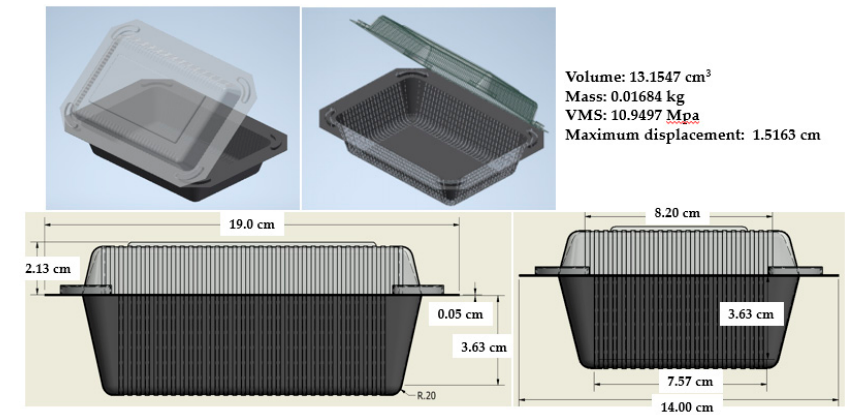
Figure 1. Final concept design of the sugar palm fiber (SPF)-reinforced sago starch biocomposite takeout food container.